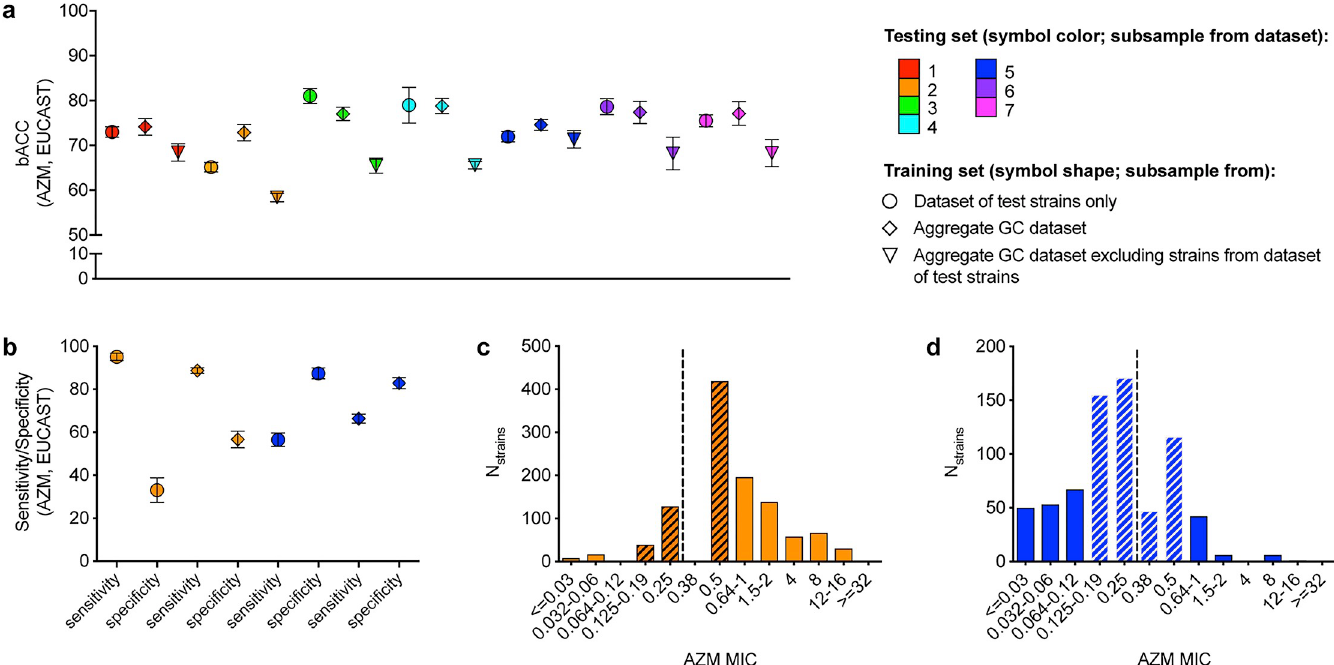
Fig 2. Differential performance of random forest classifiers across different datasets. (a) Mean balanced accuracy (bACC) with 95% confidence intervals of RF-C predictive models for gonococci (GC) azithromycin (AZM) non-susceptibility based on the EUCAST breakpoint. (b) Mean sensitivity and specificity with 95% confidence intervals of RF-C predictive models for GC AZM non-susceptibility in datasets 2 and 5. Histograms showing the distributions of AZM minimum inhibitory concentrations (MICs) in (c) dataset 2 and (d) dataset 5. Symbol colors in (a) and (b) indicate the dataset from which the testing set was derived, while symbol shape in (a) and (b) indicates the dataset from which the training set was derived. Hatching in (c) and (d) indicates MICs within one doubling dilution of the EUCAST breakpoint (designated by dashed lines).